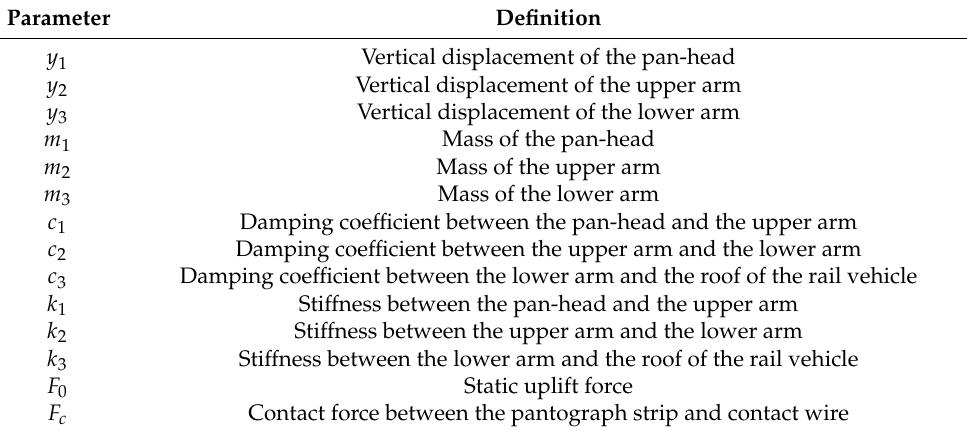
Table 2. Definition of parameters of the pantograph model.